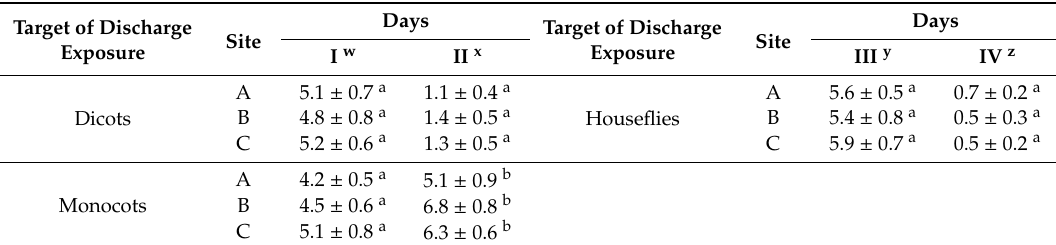
Table 3. Survey of triplicate EIE / EWEs for their ability to simultaneously control plant shoots and adult houseflies emerging from soil under greenhouse